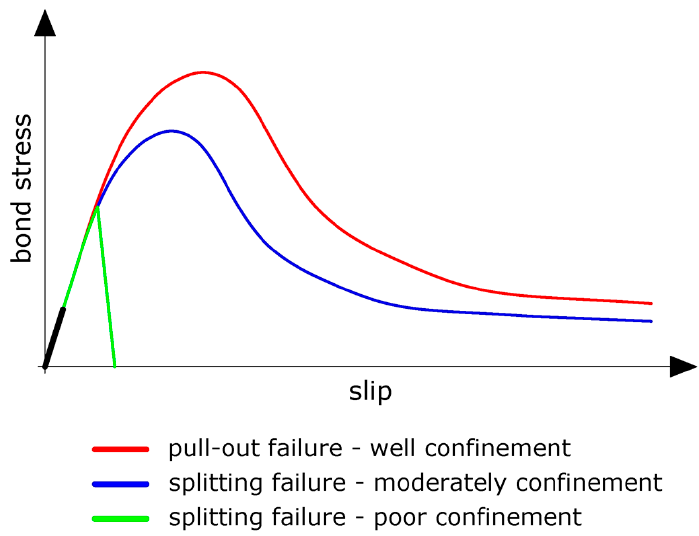
( s ) curves corresponding to type of bond (cid:4666) s (cid:4667) curves corresponding to type of bond failures. Figure 2. Example of τ b b